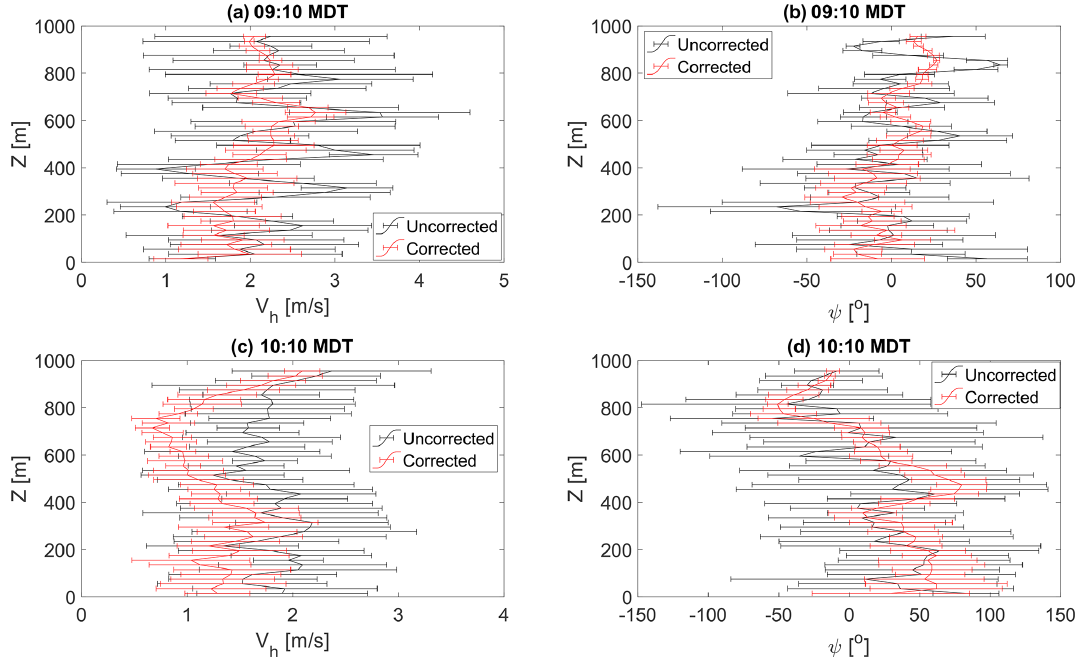
Figure 7. Comparison of mean (a) horizontal wind speed and (b) direction profiles measured by sUAS 2 at 09:10MDT with and without correction applied. Horizontal wind speed and direction profiles measured at 10:10MDT are shown in (c, d) , respectively.